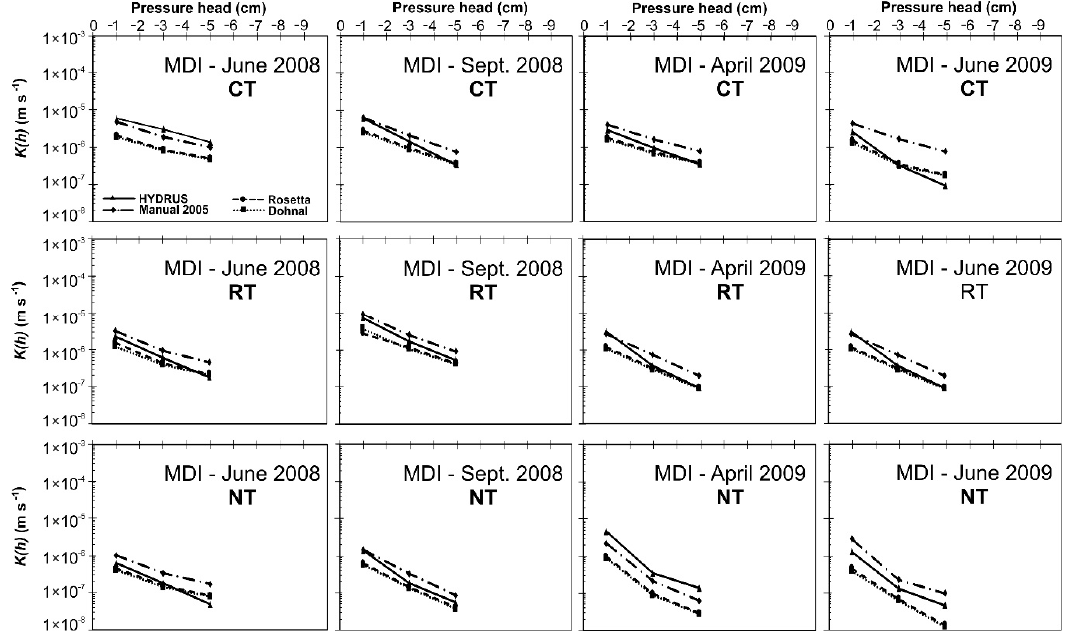
Figure 3. Overview of K(h) data determined by MDI with use of four different data analysis methods.